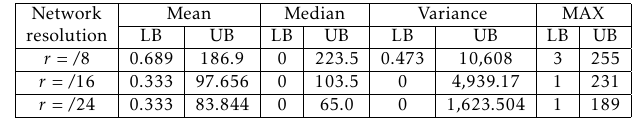
Table 2. Basic statistics of times series X